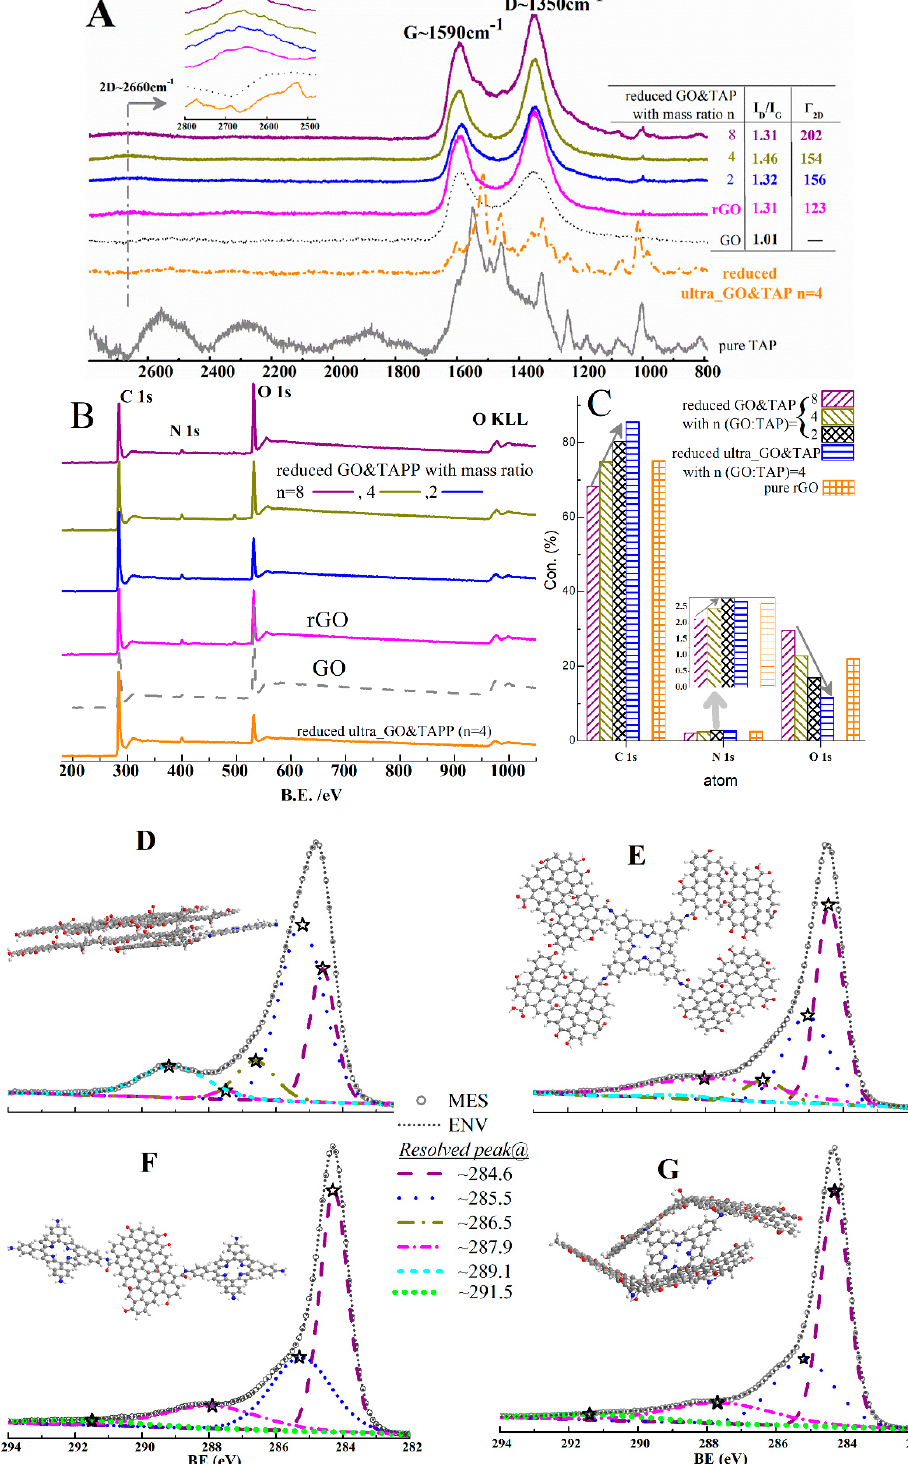
Figure 3. Characterizations of TAP-rGO samples that are the reduced products of GO&TAP (with mass ratios ( n = GO:TAP) of 8, 4 and 2) and ultrasonically pretreated GO&TAP (ultra_GO&TAP, n = 4). ( A ) Raman spectra. ( B ) XPS wide spectra. ( C ) Main elements’ contents. ( D ) to ( G ) are the C 1s core spectra and the X-ray photoelectron spectroscopy (XPS) peak-di ff erentiating analyses for the reduced products of GO&TAP n = 8 ( D ), 4 ( E ), and 2 ( F ) and the reduced ultra_GO&TAP ( G ). Data analyses for B to G are executed by CasaXPS Version